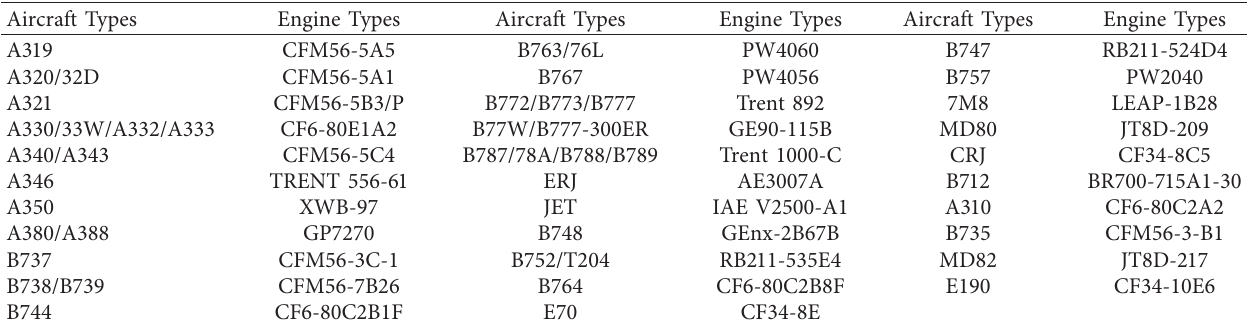
Table 3: Comparison table of civil aviation